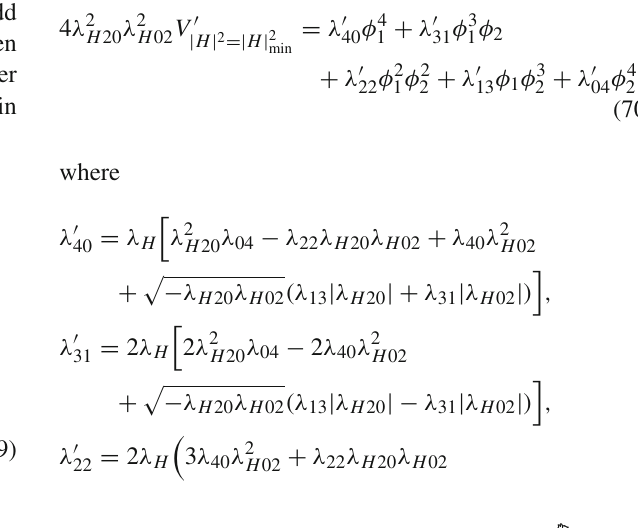
is rather | H | 2 =| H | 2 min